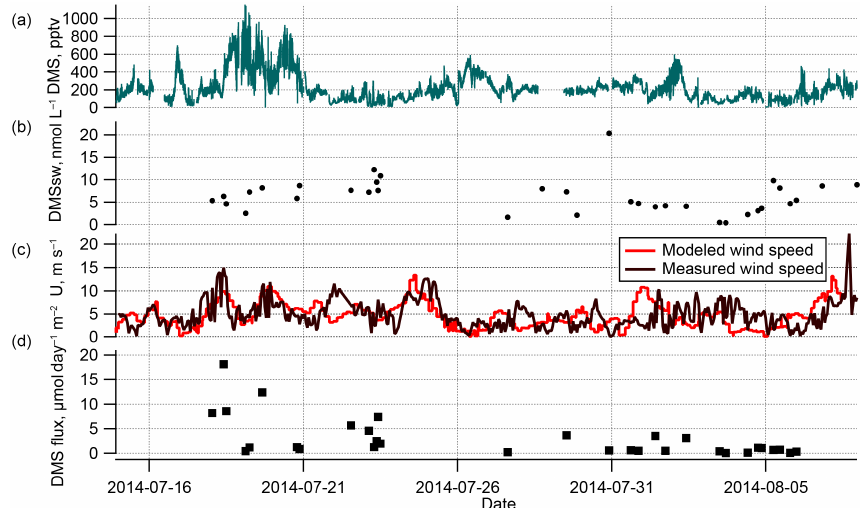
Figure 2. Time series along Amundsen ship track of (a) atmospheric DMS mixing ratio (10Hz) from HR-ToF-CIMS, (b) observed DMS surface seawater concentration, (c) hourly-averaged wind speed at ship position (black) and hourly-average GEOS wind speed at ship position (red), and (d) DMS water-air flux estimates. Table 2. Summary of previous air–ocean DMS flux values in the Arctic.